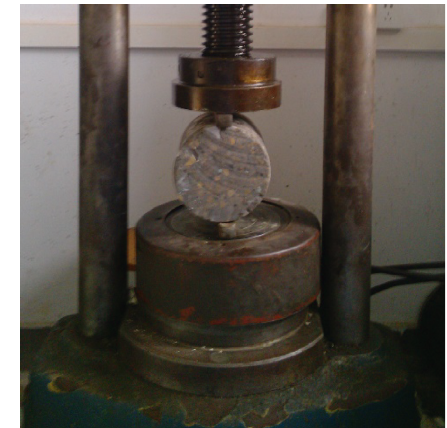
Figure 11: Setup of IDT test.